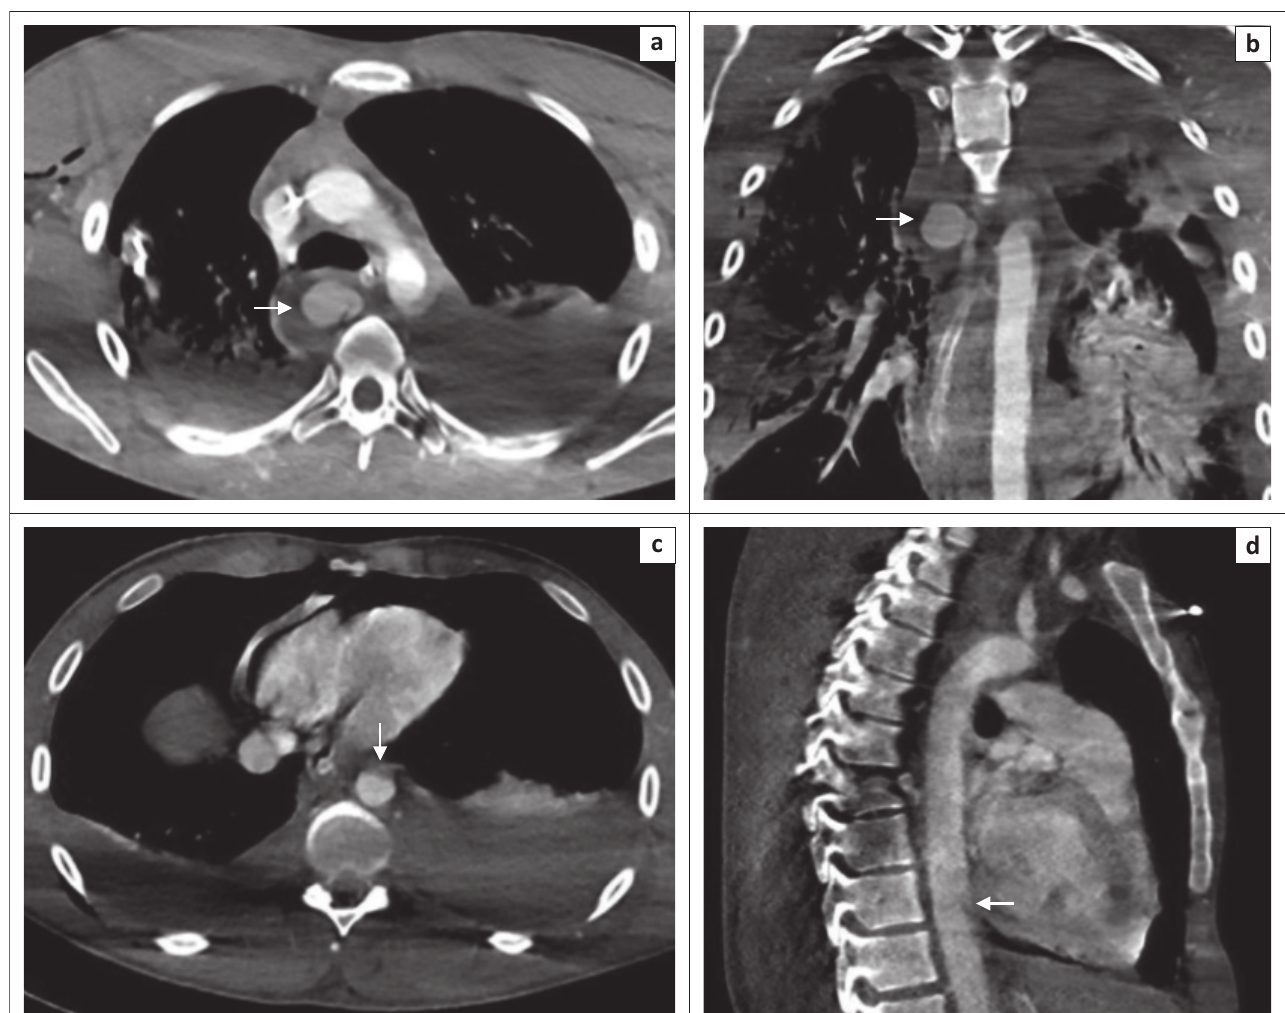
FIG URE 8: Thick arrows in (a) and (b) demonstrate an azygous arch pseudoaneurysm and surrounding mediastinal haematoma. Arrows in (c) and (d) in the same patient show anterior wall irregularity (indirect sign) in the lower thoracic